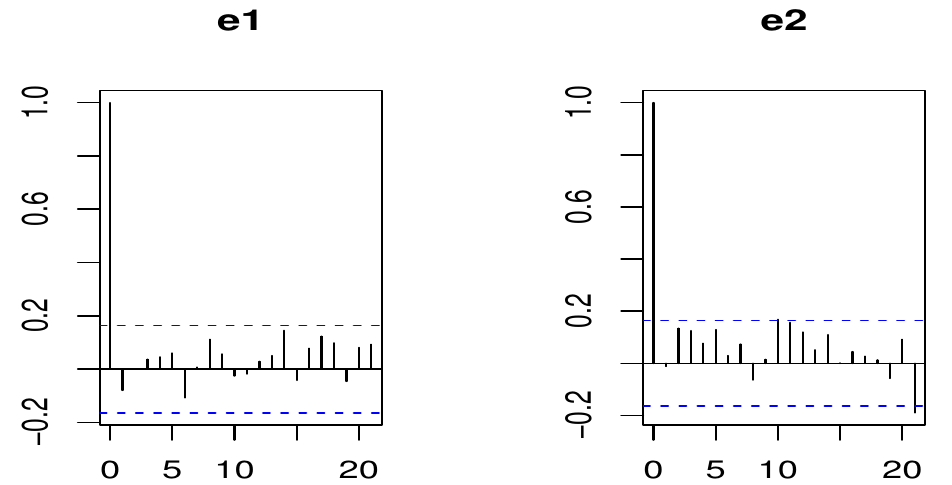
Figure 5. ACF of standardized residuals of CDRUGS and CSHOTS data for the BINAR(1)BP2S-L(II) process.